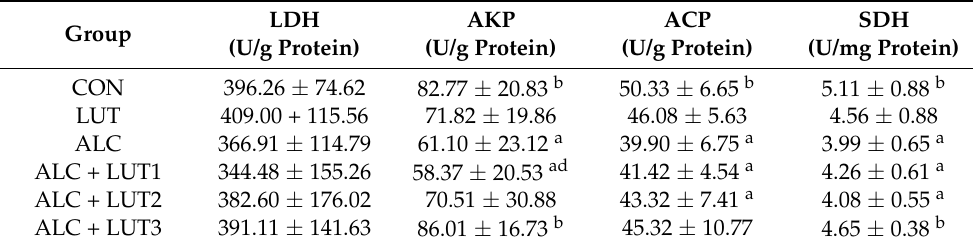
group, p < 0.05. (n = 10, mean ±